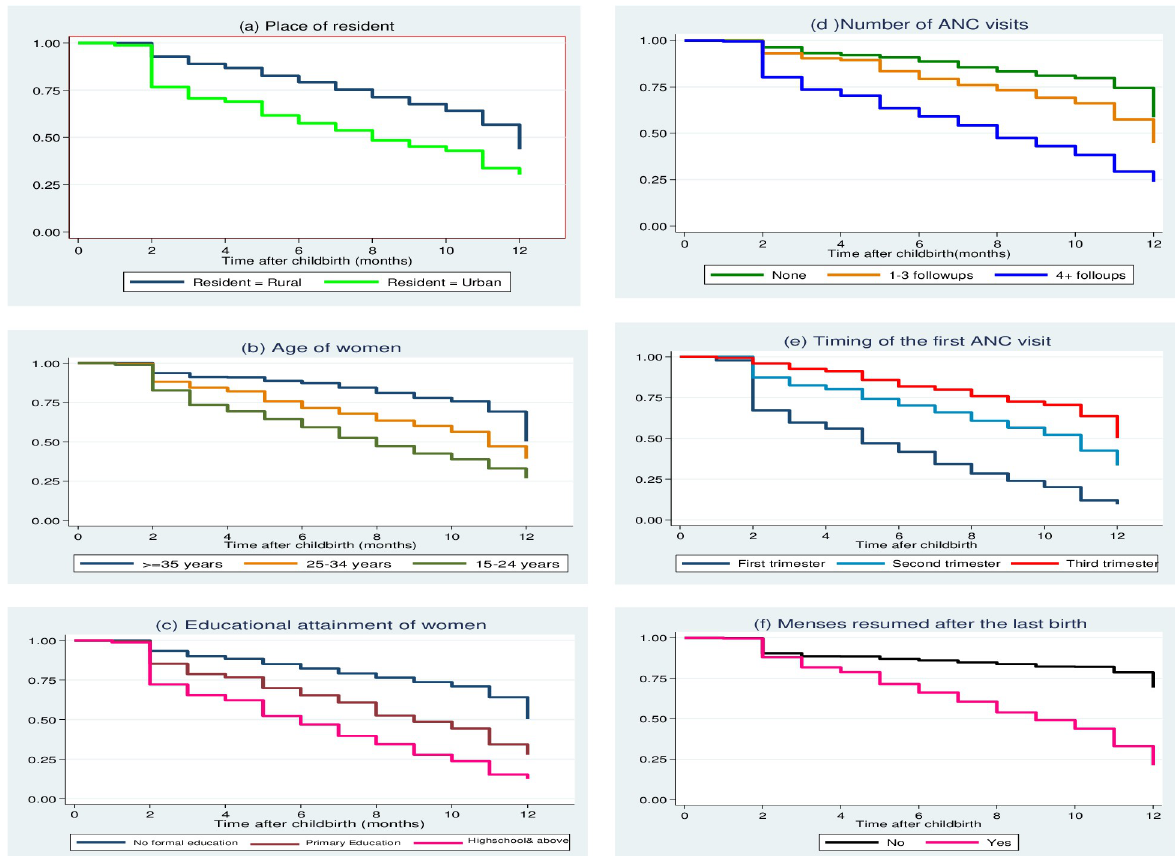
Fig 2. Kaplan Meier estimate curve of postpartum family planning use within 12 months from childbirth by selected characteristics of women, Northwest Ethiopia, June 2018.